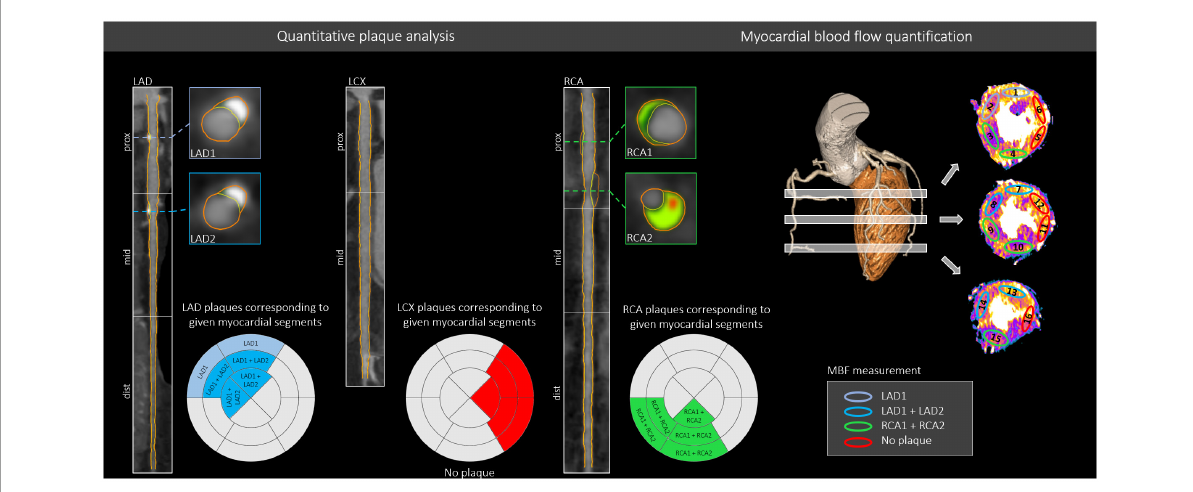
FIGURE4 Comprehensive plaque assessment and the evaluation of myocardial ischemia based on CT images. A representative case of our study depicts the images of a 62-year-old male patient who underwent coronary CTA and DPCT imaging for the evaluation of CAD and corresponding myocardial ischemia. In this case, plaques were detected and quantified in the proximal LAD (LAD1), mid-LAD (LAD2) and proximal RCA (RCA1 + RCA2) coronary segments. All coronary plaques based on their location were matched for a given myocardial territory. MBF was quantified for all 16 myocardial segments using DPCT images. By creating a myocardial vessel territory map for each coronary segment, we could derive the total plaque volume that possibly influences the blood flow quantified as MBF on DPCT to any of the 16 analyzed LV territories (see Figure 2 for segmental classification). In this case, basal anterior (1) and basal anteroseptal (2) myocardial segments were influenced by the proximal LAD (LAD1) lesion, while the mid anterior (7), mid anteroseptal (8), apical anterior (13), and apical septal (14) myocardial segments were affected by two lesions: LAD1 and LAD2 (mid LAD segment) as they are located more distally. No plaques were present in the LCX. Regarding the RCA, two plaques were detected in the proximal RCA segment (RCA1 and RCA2), therefore all myocardial segments corresponding to the RCA were influenced by two plaques (RCA1 and RCA2). Plaque volumes of the lesions aligned for a given myocardial segment were summed and accounted for in the analysis, while the highest degree of lumen area stenosis of the corresponding lesions was included in the analysis. Light blue color indicates LV segments related to proximal LAD lesion, dark blue color indicates LV territories related to both proximal and mid-LAD lesions, whereas green color shows myocardial territories corresponding to the RCA lesions. LCX demonstrated no coronary lesions. ROI-s were placed in each myocardial segment on short-axial images. CAD, Coronary artery disease; CTA, CT angiography; DPCT, Dynamic perfusion CT; LAD, Left anterior descending; LCX, Left circumflex; LV, Left ventricle; MBF, Myocardial blood flow; RCA, Right coronary